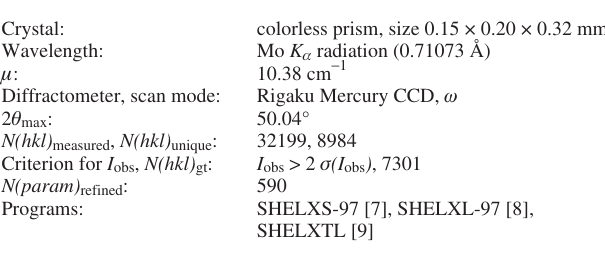
Table 1. Data collection and handling.